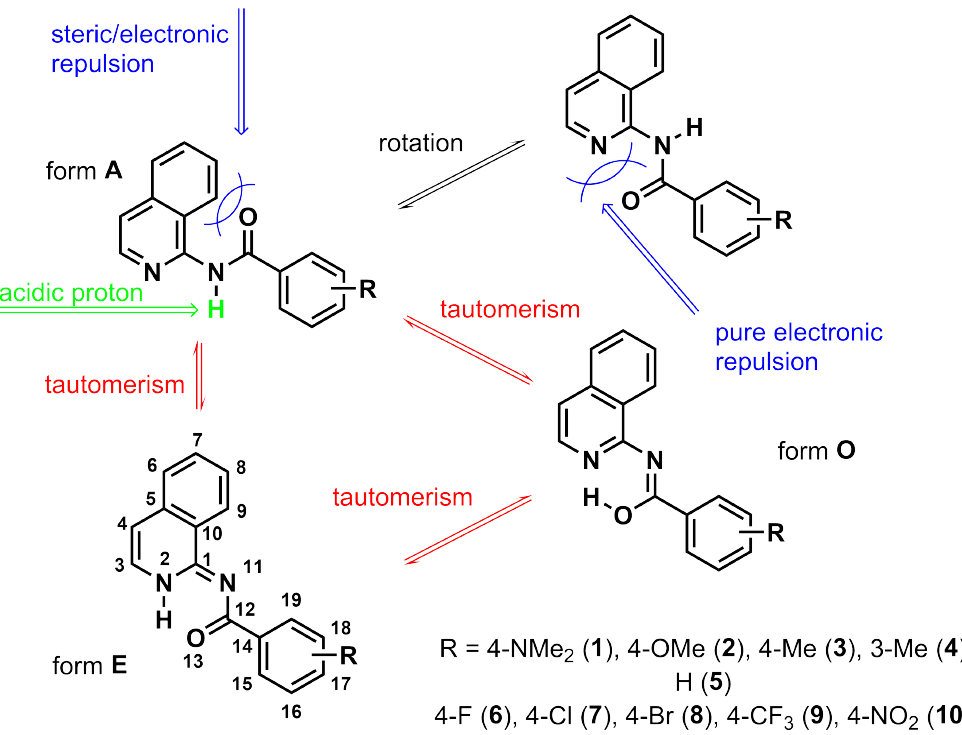
Figure 1. The tautomerism and steric/electronic repulsion in the studied series of